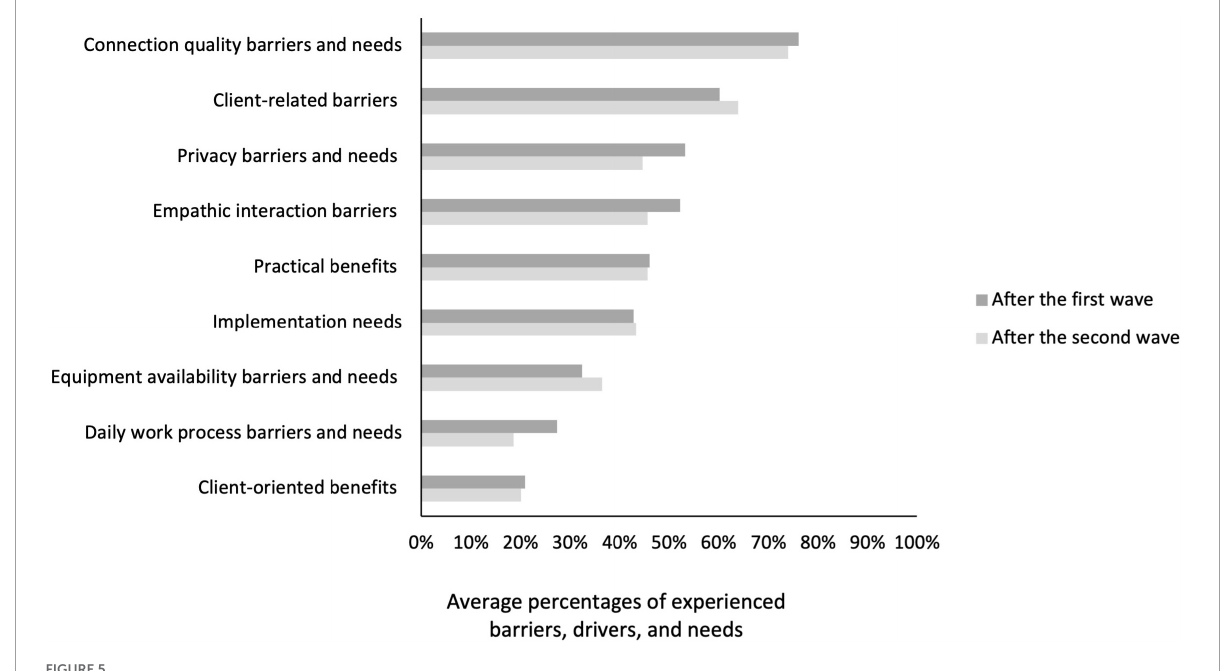
FIGURE5 Average percentages of experienced barriers, drivers, and needs by practitioners during Survey 2 and